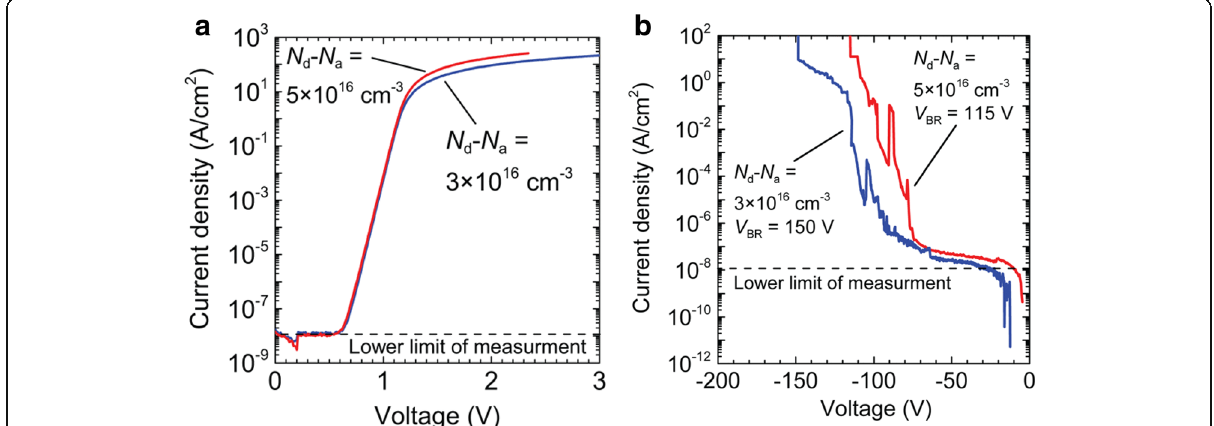
Fig. 5 a , b Forward and reverse electric characteristics of the SBD based on (010) β -Ga 2 O 3 substrates with different doping concentrations. The lower limit of current density measurment is 10 -8 A/cm 2 . Reprinted from ref.